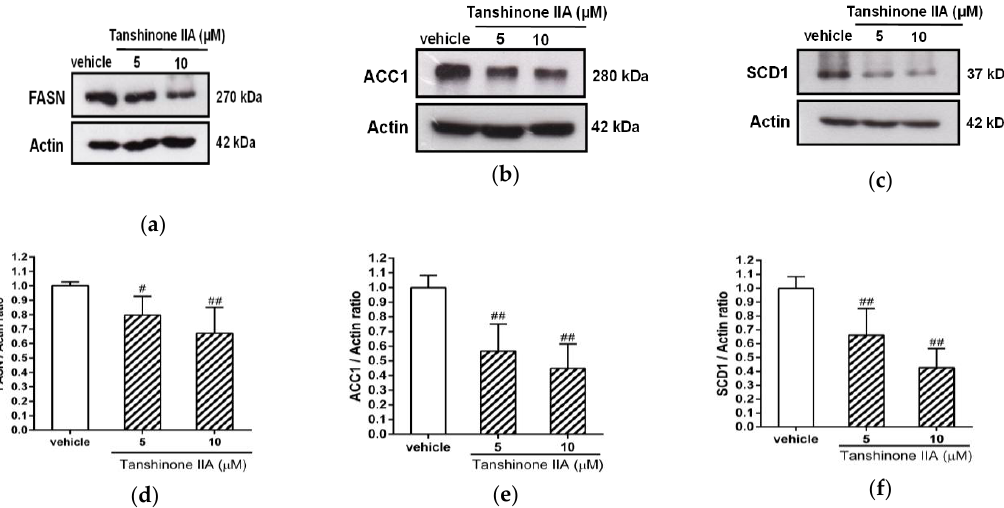
Figure 3. Effects of tanshinone IIA on FASN, ACC1, and SCD1 protein expression in HepG2 cells. HepG2 cells were treated with vehicle (0.1% DMSO) or tanshinone IIA (5 and 10 μM) for 24 h. The protein expression of ( a ) FASN, ( b ) ACC1, and ( c ) SCD1 was measured by Western blot analysis. A representative blot is shown. The normalized intensities of ( d ) FASN, ( e ) ACC1, and ( f ) SCD1 proteins versus actin are presented as the mean ± SD of three independent experiments. # p < 0.05 and ## p < 0.01 indicate significant differences compared to the vehicle-treated cells.